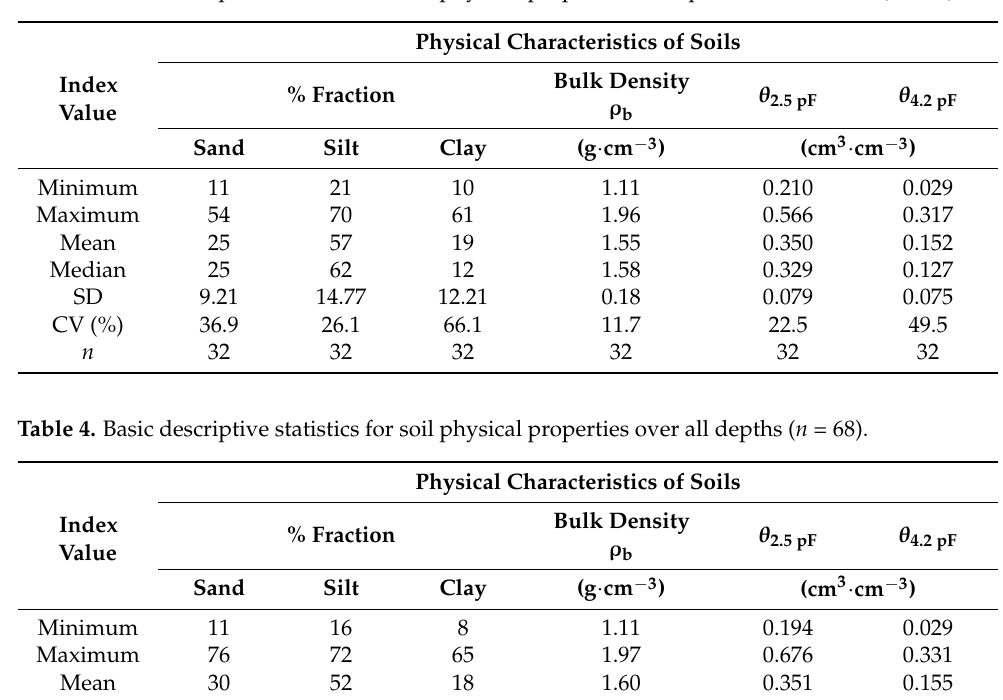
Table 3. Basic descriptive statistics for soil physical properties for topsoils and subsoils ( n = 32).